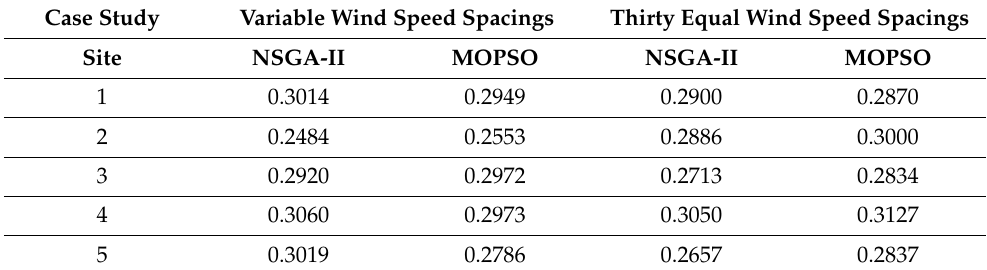
Table 10. Comparison between NSGA-II and MOPSO using the hyper volume